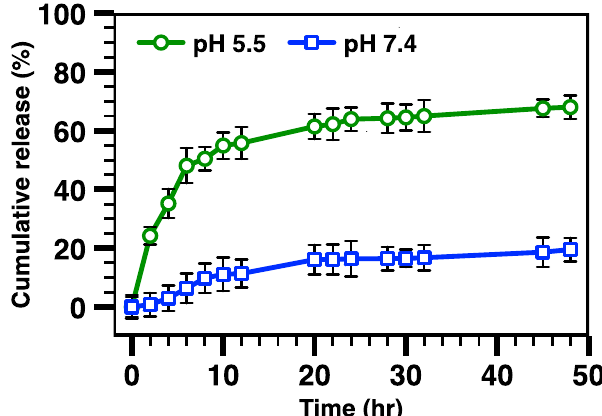
Figure 7. DOX release profiles from the PDC (5) micelles at pH 5.5 and 7.4 at 37 °C. Each data points with error bars represent the mean value ± the standard deviation obtained from three independent measurements.